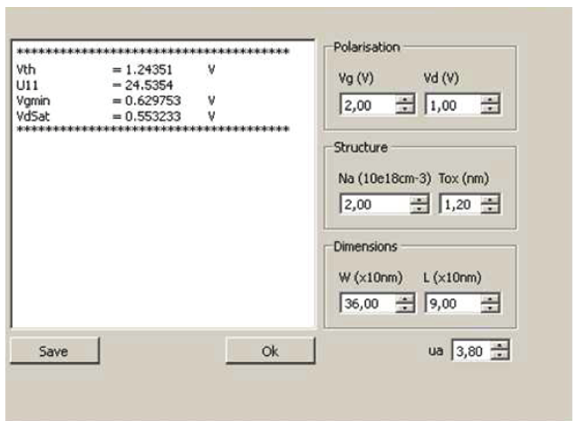
Figure 19: The graphic user interface.